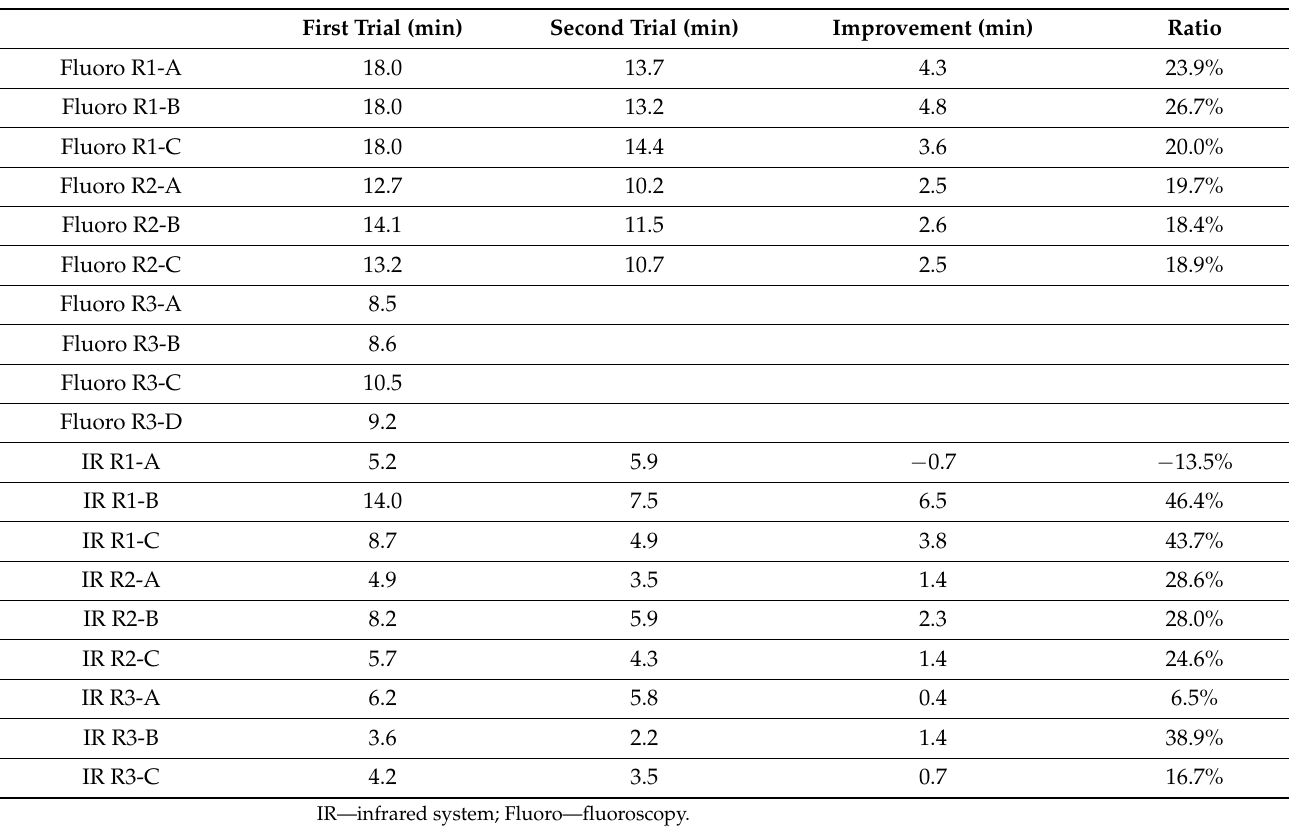
Table 1. Total manipulation time of all participants in the two training courses.